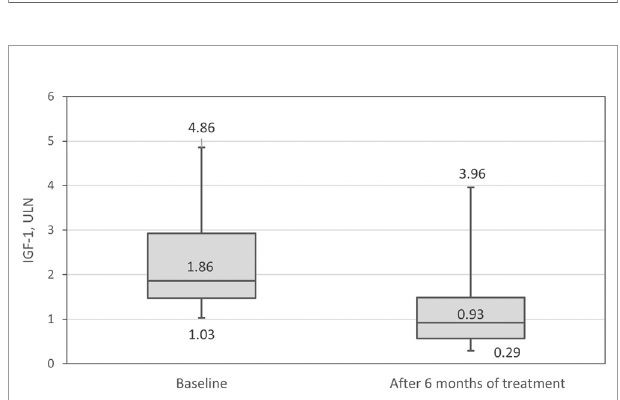
FIGURE 5 | Growth hormone (GH) at baseline and after 6 months of treatment.